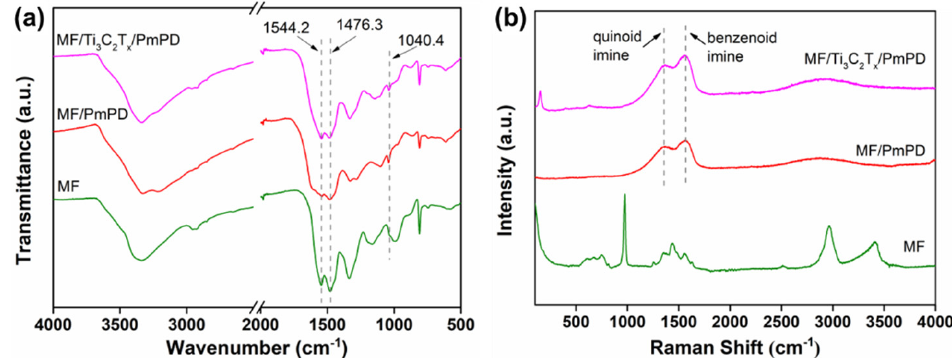
Figure 3. FT-IR ( a ) and Raman ( b ) spectra of MF, MF/PmPD and MF/Ti 3 C 2 T x